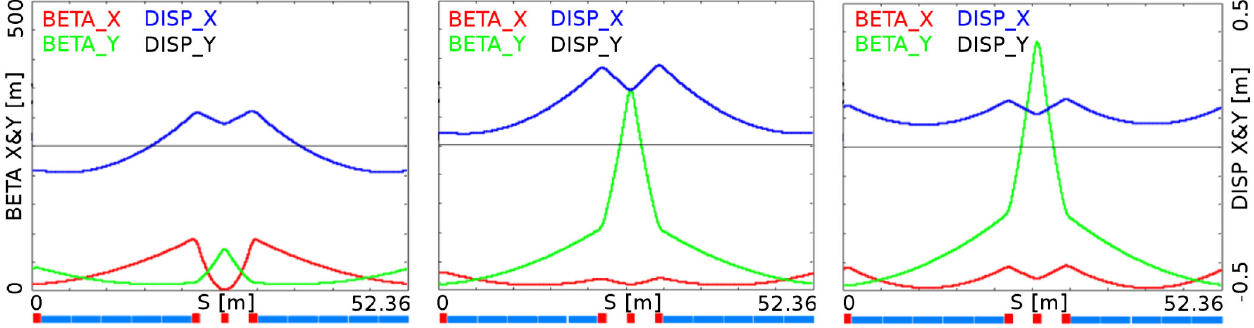
FIG. 4. Lattice cells of arc1 and arc2 (left), arc3 and arc4 (center), and arc5 and arc6 (right).